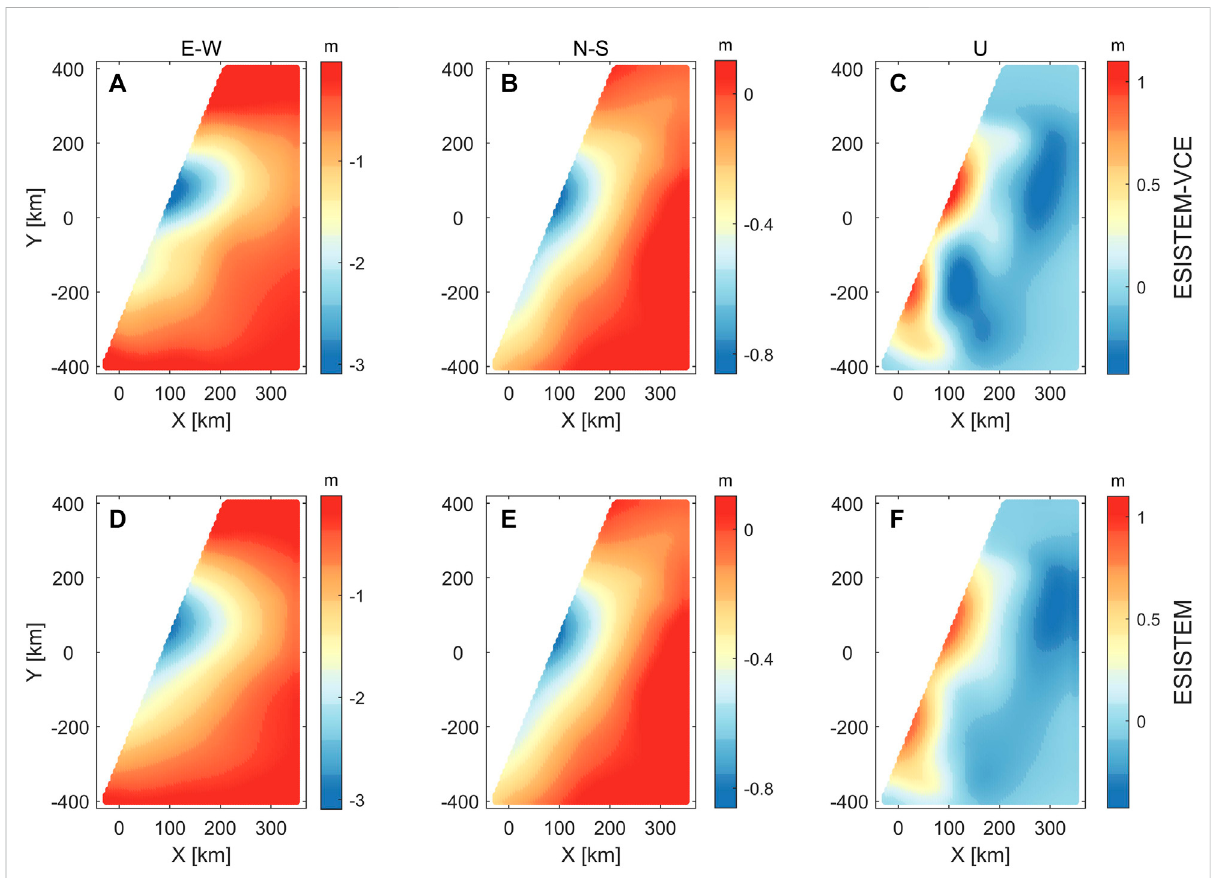
FIGURE 4 Solutions of ESISTEM-VCE and ESISTEM methods for simulation example. The upper row (A-C) is from the ESISTEM-VCE method, the low row (D-F) is from the ESISTEM method.